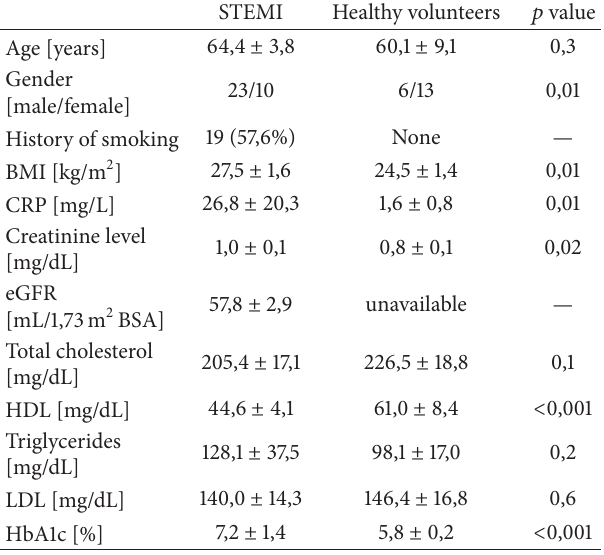
Table 2: The comparison of demographic and biochemical data of 33 STEMI patients and 19 healthy volunteers. The analysis was made using 𝑡 -test and Kolmogorov-Smirnov test.